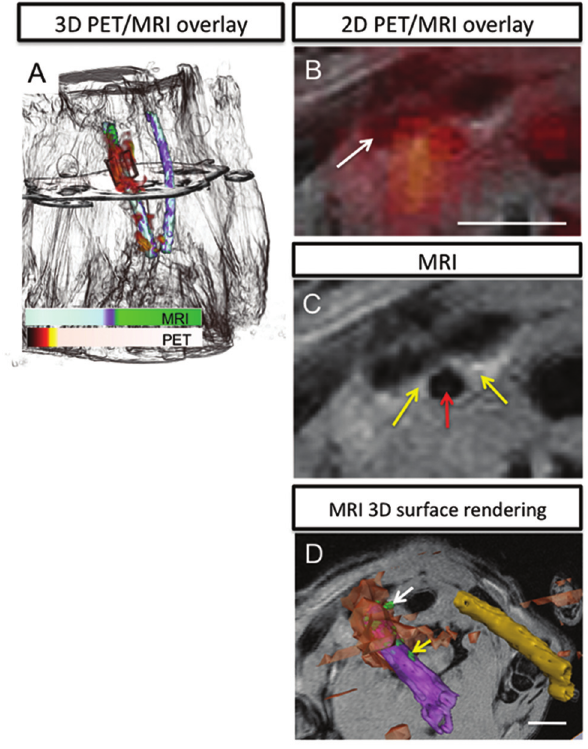
Figure 3. Multimodal macromolecular probes localize to the injured vessel in the rat copper cuff model. (A) Overlay of PET with MRI for nearly whole body 24 h post injection of the PET/T1-MRI probes (head at top, out of field of view). Probe accumulation as monitored by PET is found in a diffuse cloud (red-orange) around the vessel that was clamped by the copper cuff, left (rendered in black and white). The PET and MR signal from vessels was rendered in color using the assignments shown in the scale bar, and MR signal from rest of the body is given in black-and-white for anatomical reference. The plane through the image indicates the position of the image slice given in (B), a view zoomed in around the carotid artery at the superior end of the copper cuff. This coregistered MRI/PET image shows diffuse cloud of PET signal in the region around the injured vessel (clavicle is the dark region indicated by the white arrow) and region of higher MR intensity on the right side of the vessel. scale bar =2.5 mm. (C) The MR image from the same plane clearly shows that the vessel (red arrow) has elevated MR contrast in the walls of the vessel (yellow arrows). (D) 3D reconstruction of MRI and PET data in an oblique orientation demonstrates the mapping capabilities for MRI, which is able to identify discrete accumulations of macrophages on the vessel wall. The indicated MR volume (green) at the white arrow is 0.74 6 0.57 6 0.46 mm 3 . The volume at the yellow arrow is 0.68 6 0.60 6 0.32 mm 3 . Scale bar =5 mm. This view is zoomed out from the FOV in panels B and C to include both vessels. Injured carotid artery is purple, increased MR signal intensity relative to vessel background is green, PET signal is orange, and contralateral vessel is gold.